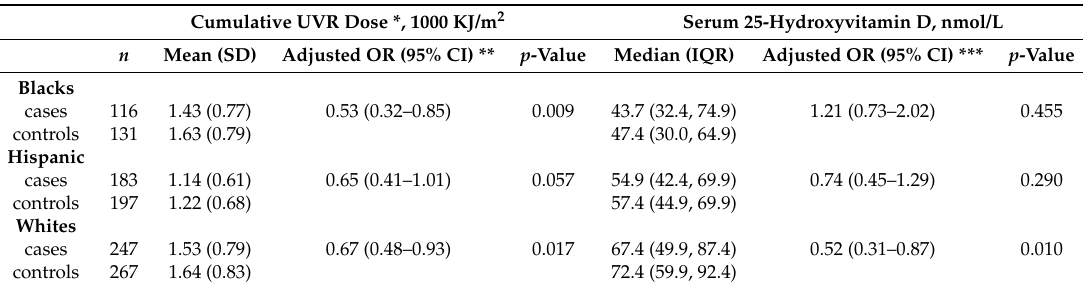
Table 2. Individual Relationships between Cumulative Ultraviolet Radiation Exposure or Serum 25-hydroxyvitamin D and Multiple